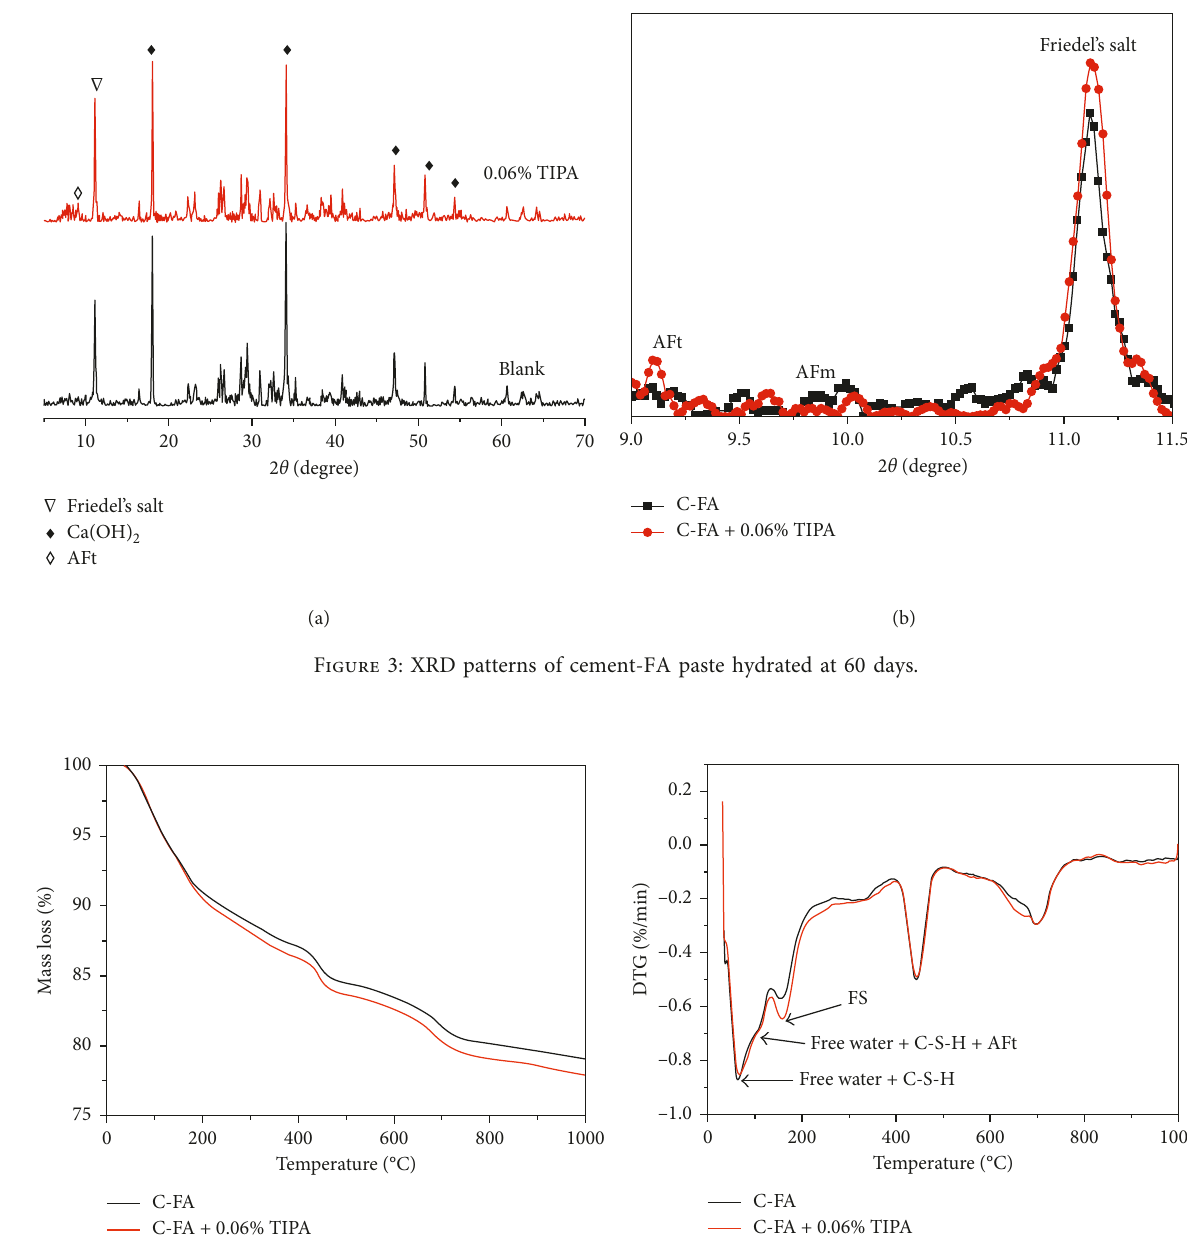
(b) Table 2: Calcium hydroxide content in the cement-FA system (wt.%).